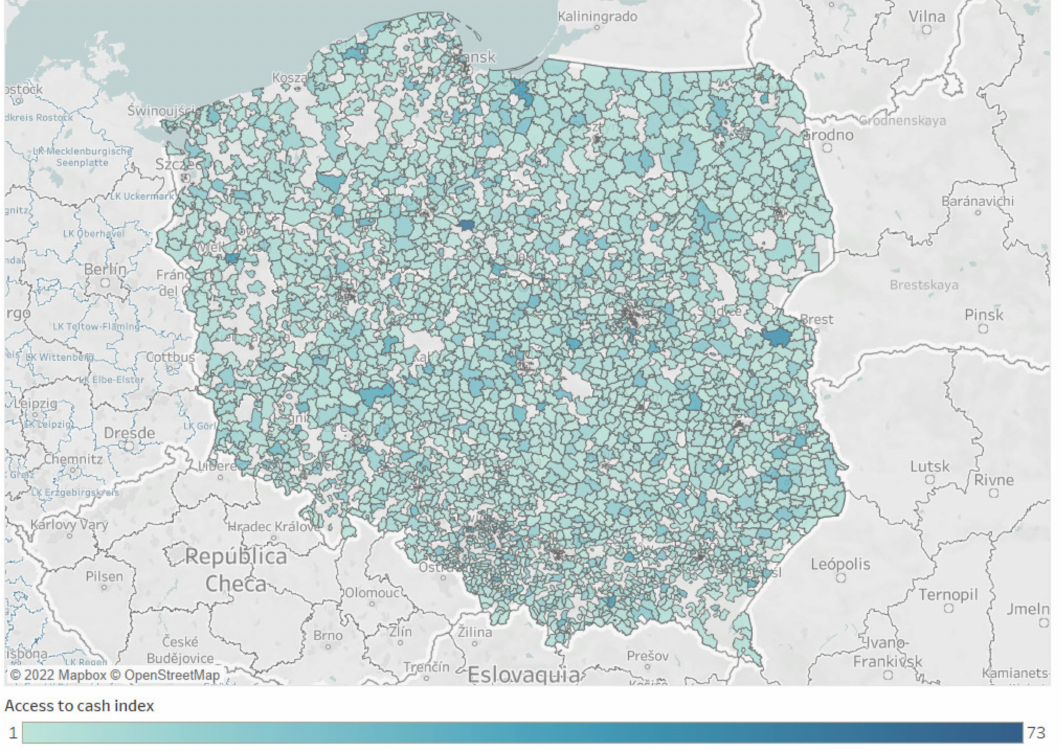
Figure A3. Map with ACI results for the whole of Poland. Source: Prepared by the authors using Tableau Desktop Professional